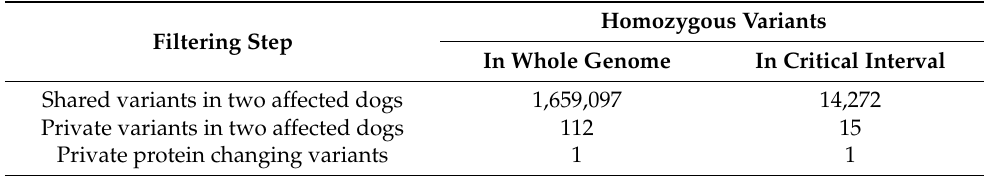
Table 5. The results of homozygous variant filtering in two affected English springer spaniels with DAMS against 784 control genome sequences. Homozygous Variants Filtering Step In Whole Genome In Critical Interval Shared variants in two affected